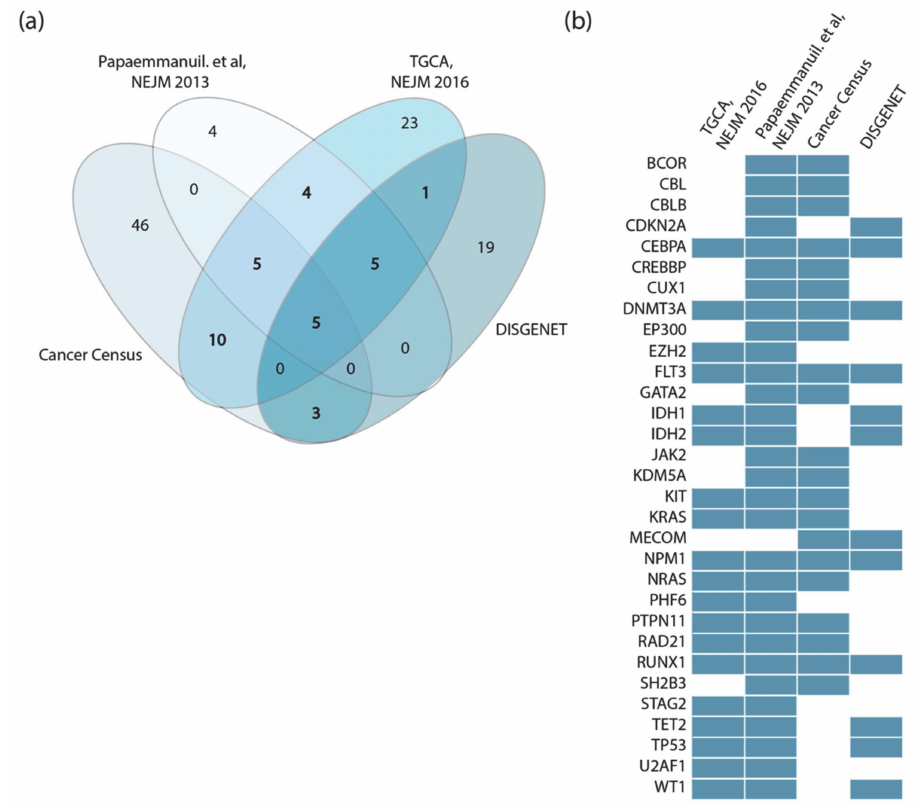
Figure 2. Acute myeloid leukemia (AML) cancer driver genes. ( a ) Venn diagram illustrating the overlap of the AML driver genes annotated in four independent resources and datasets. ( b ) Heatmap showing the 31 AML driver genes identified (blue rectangles) or not identified (white rectangles) in each indicated dataset. Only genes annotated in at least two resources are